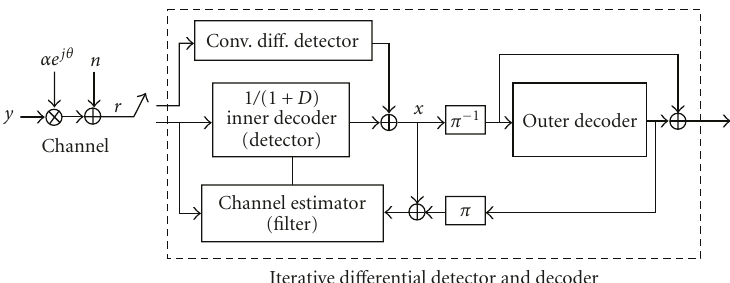
Figure 6: Structure of iterative di ff erential detection and decoding